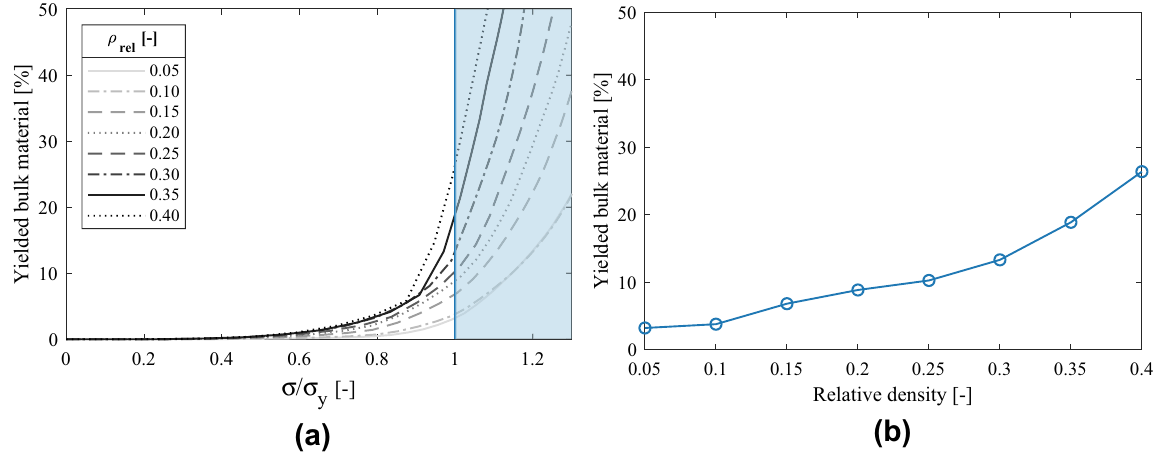
Figure 9. ( a ) Evolution of bulk material yielding for different relative densities, ( b ) proportion of yielded bulk material at macroscopic 0.2% offset yield stress for different relative densities.